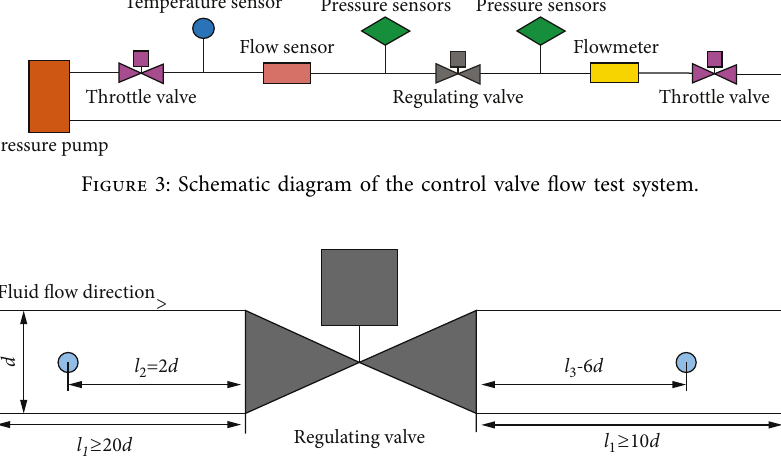
Figure 4: Nominal pipe size and adjustment position. Table 2: Variation of opening and flow coefficient.